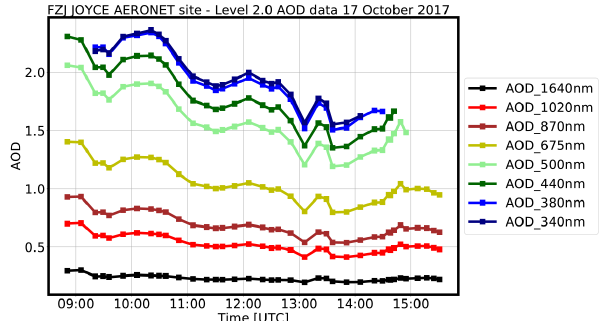
Figure 10. Wavelength variation of AODs measured at the AERONET site in Jülich in Germany on 17 October 2017. Data are level 2.0 (v3). The large wavelength variation seen here indicates that small submicron particles have dominated the